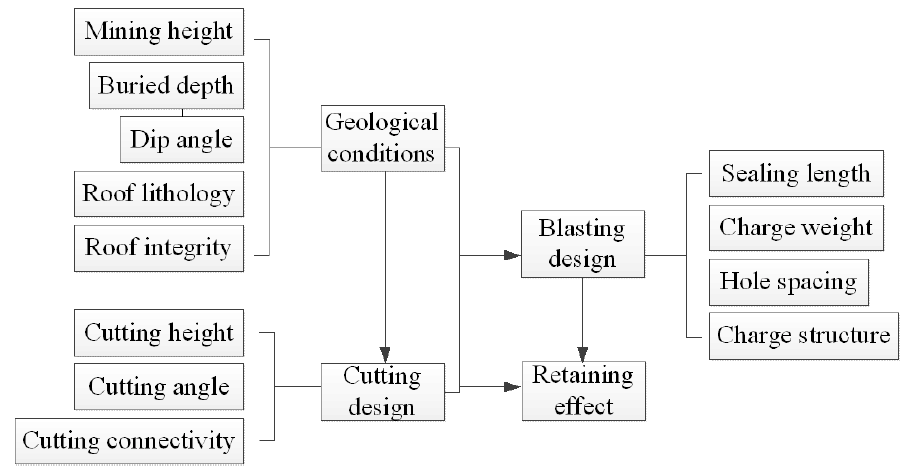
Figure 13. Relationship diagram of roof cutting and blasting design.